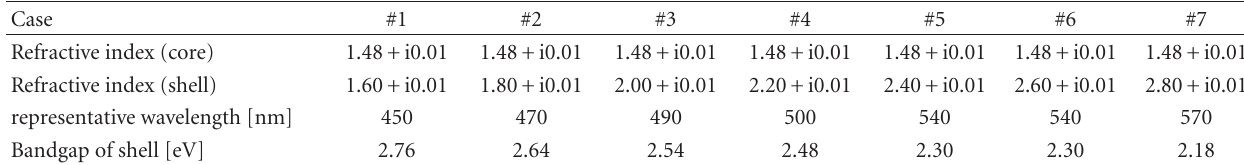
Table 1: Parameters for modeling and resulting absorption